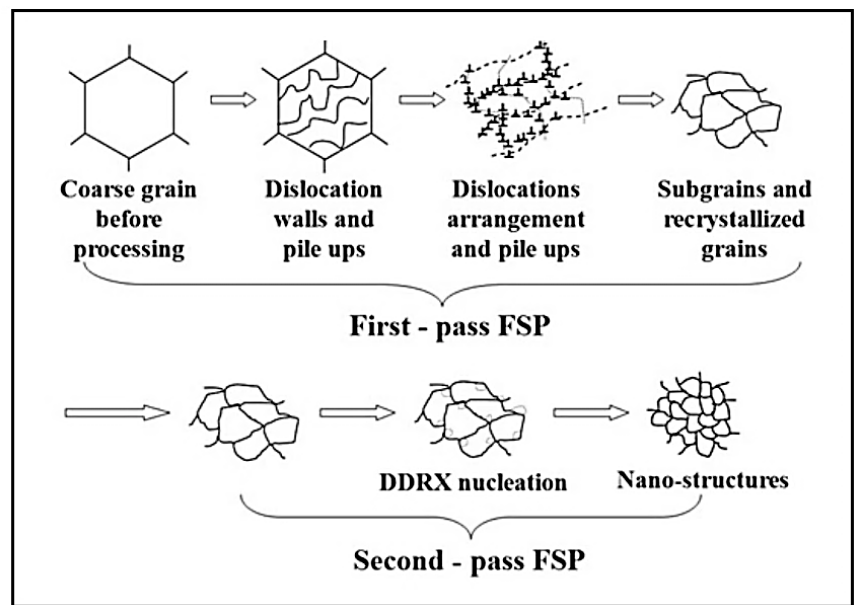
Figure 10. Schematic illustration of the grain refinement process of the two-pass FSP AZ31 Mg specimens (Reprinted with permission from ref. [54]. Copyright 2008 Acta Materialia